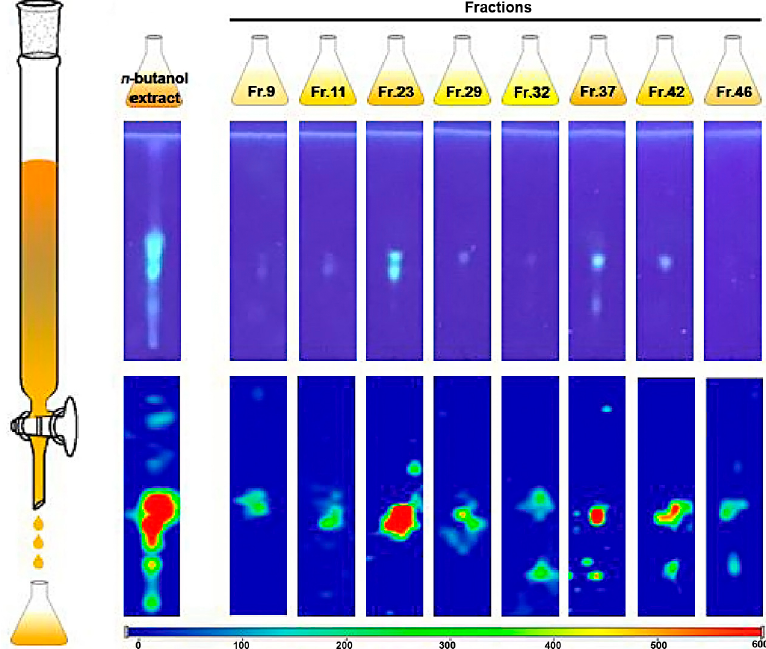
Figure 4. Schematic of the proposed TLC-SERS method for n-butanol extract detection [109]. Reproduced with permission from [109]. Copyright Elsevier, 2018.